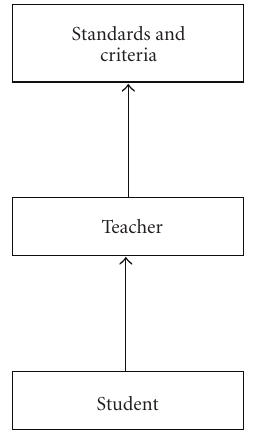
Figure 2: Teacher-mediated standards in reliant self-assessment.